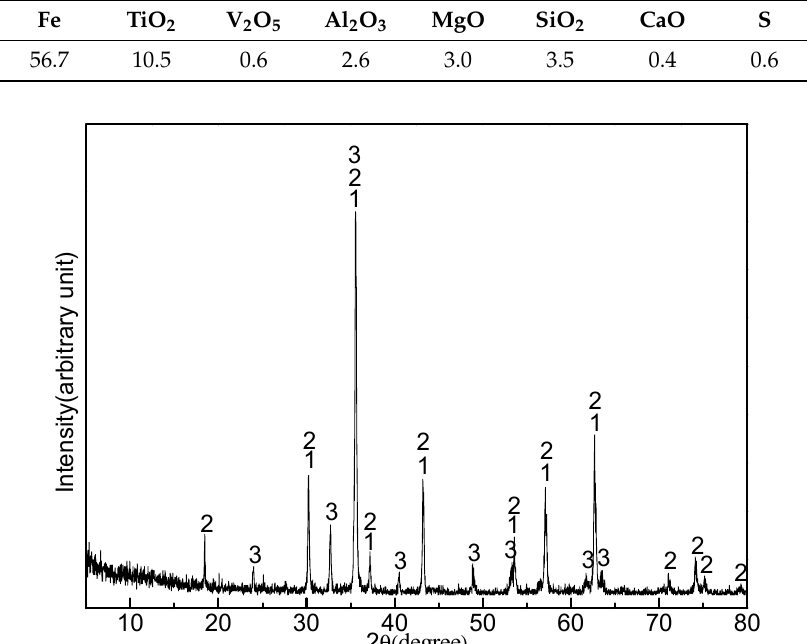
Table 1. Chemical compositions of TMCs (mass %).